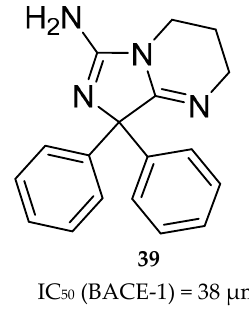
Figure 31. Bicyclic aminoimidazole hit compound 39 .